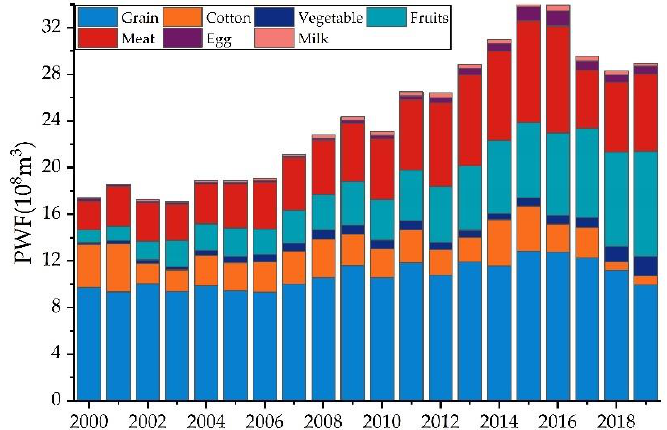
Figure 3. PWF of different agricultural products in Hotan region during 2000–2019.